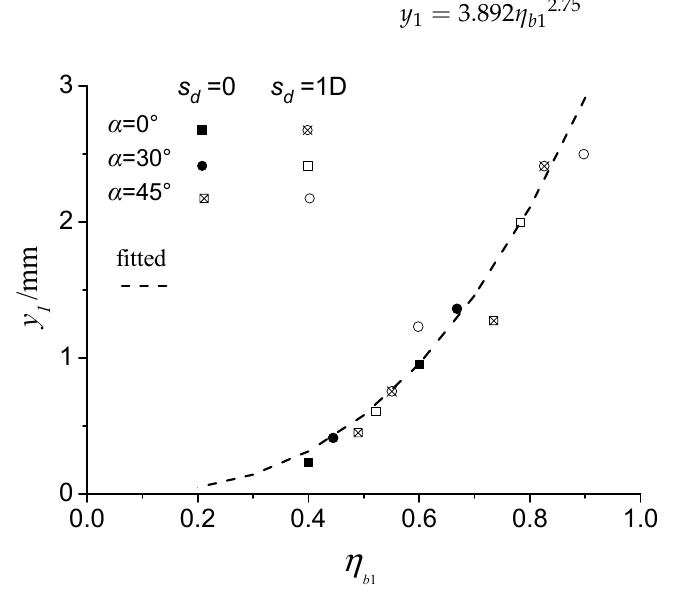
Figure 18. The value of y (cid:2869) to the cyclic amplitude η (cid:2912)(cid:2869) .